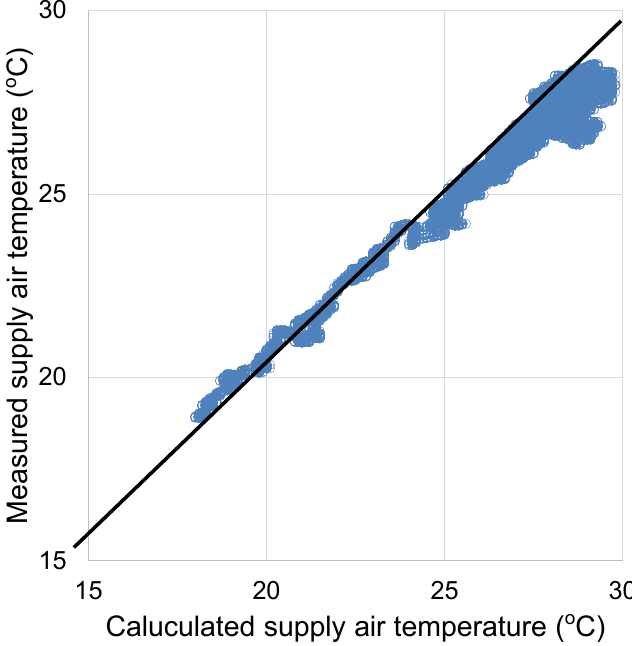
Figure 4. Correlation between measured and calculated supply air temperature.